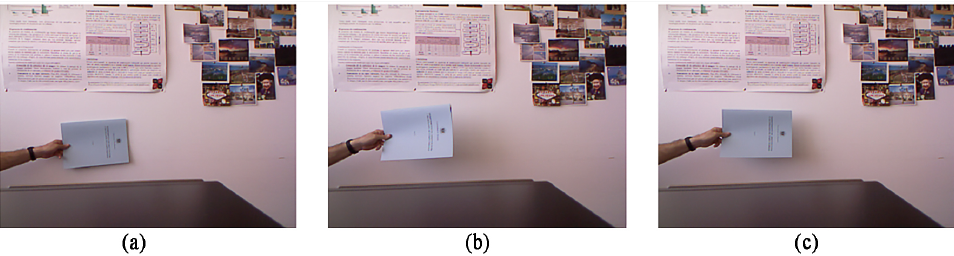
Figure 7. Depth sampling map of Experimental Scenario One: ( a ) the 74th frame; ( b ) the 94th frame; ( c ) the 134th